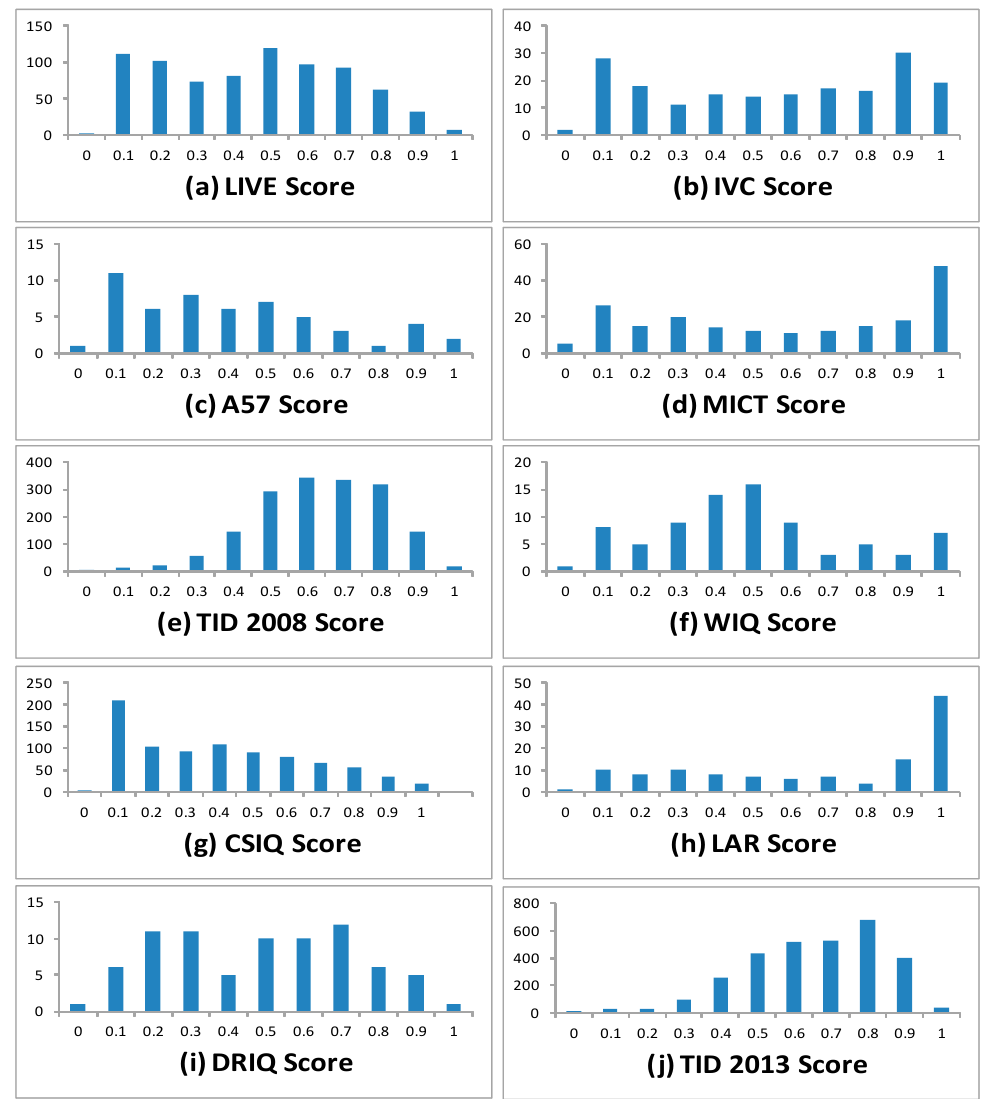
Figure 1. Histogram plot for normalized MOS widely used benchmark database.